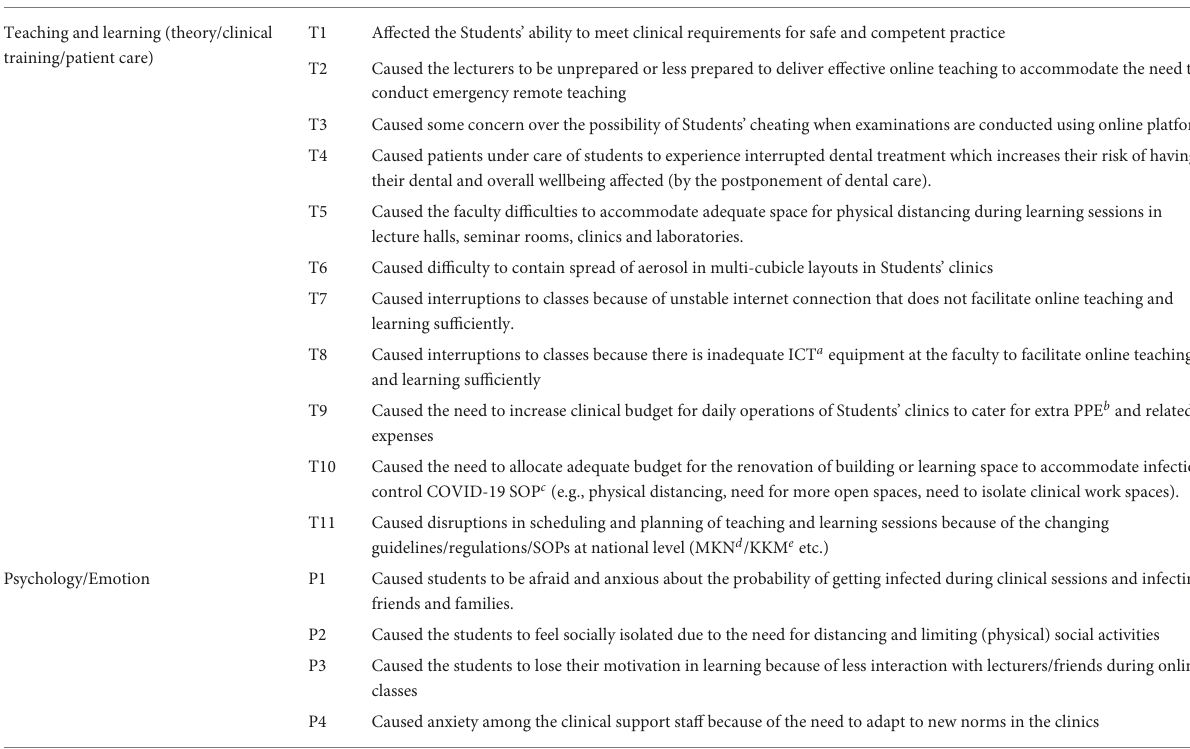
TABLE 1 Impact statement of COVID-19 on dental undergraduate